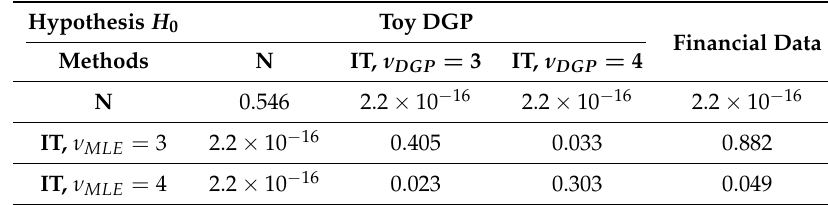
Table 8. All datasets: the p -values of the Mahalanobis distances tests with the null hypothesis and the corresponding